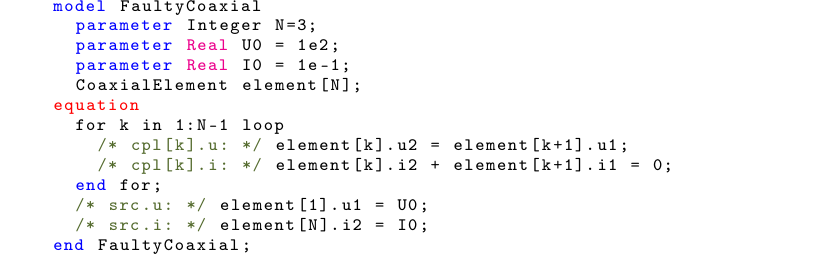
Figure 15. Assembly of N instances of transmission line elements.